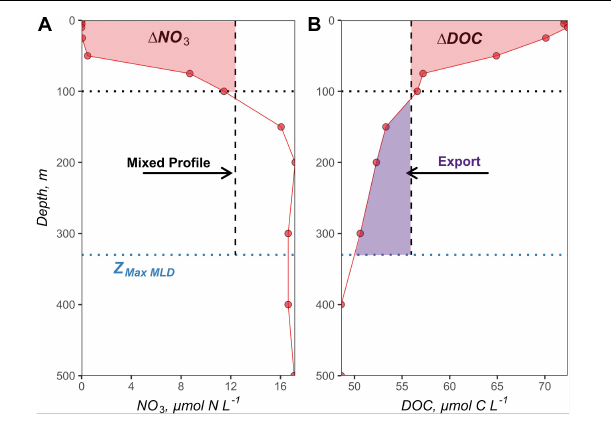
FIGURE 3 | Early autumn nitrate (A) and DOC (B) profiles from station 5 at 51.7 ◦ N and − 39.5 ◦ W. The maximum MLD ( Z Max MLD ) at the 50 ◦ latitudinal bin recorded by ARGO floats was 330 m and is shown as the blue dotted line. The black dotted line indicates the 100 m depth horizon, used as a benchmark for the surface layer as in previous studies. The vertical black dashed line represents the redistribution of the observed profiles to the maximum MLD (integrated and depth-normalized to maximum MLD ), simulating the “mixed” condition reflective of winter/spring deep convection. The red shaded areas within the surface 100 m represent (A) the nitrate drawdown and (B) the accumulation of (cid:49) DOC between the time of mixing to the early autumn stratified period in mol N m − 2 and mol C m − 2 , respectively. The purple shaded area below the 100 m depth horizon indicates